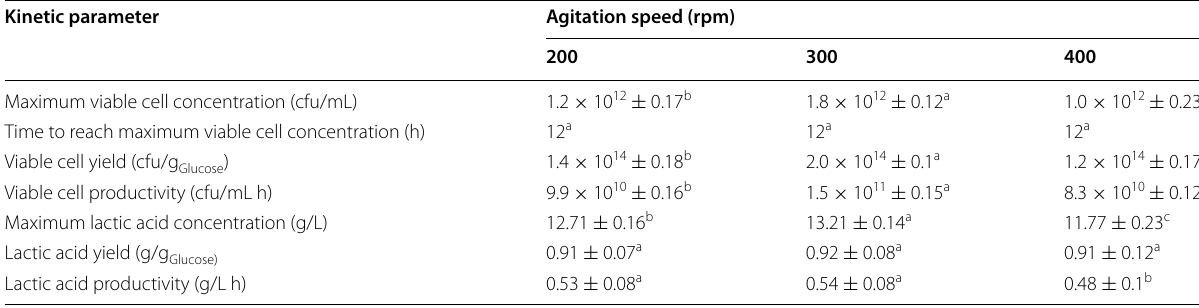
The results presented are the average of triplicate experiments and are expressed as mean a,b,c Mean values in the same row with different superscripts are significantly different from each other (P < 0.05)